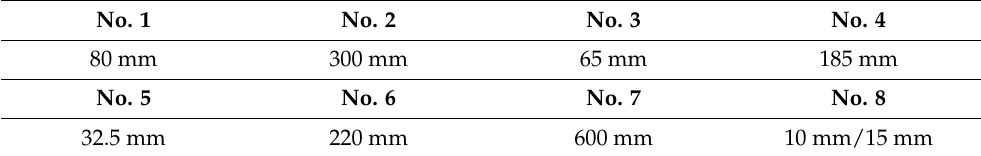
Figure 14. The final model of the DC corona, the shield and shield ring of the top insulator. ( a ) corner. ( b ) side. ( c ) shield ring. Table 6. The design factors of the DC corona shield